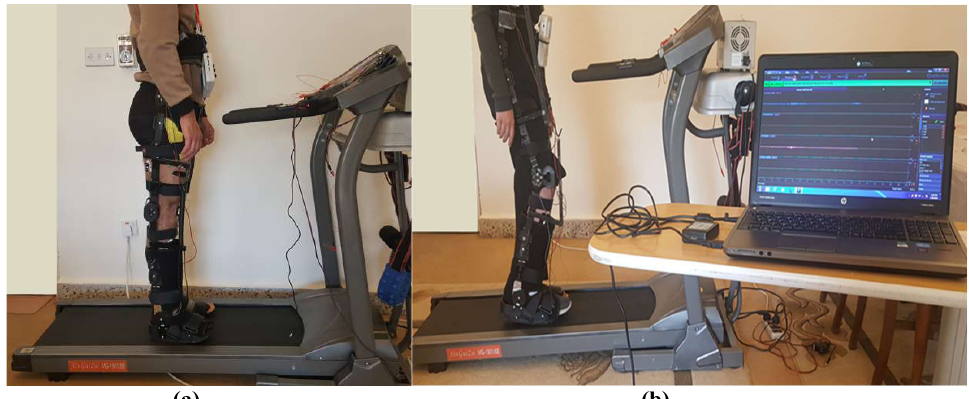
Fig.11. Experimental tests on participants (a) healthy subject (b) subject with unilateral (right) lower limb weakness. Participants Basic information. Participant condition Age Gender Healthy Unilateral (right) lower limb weakness